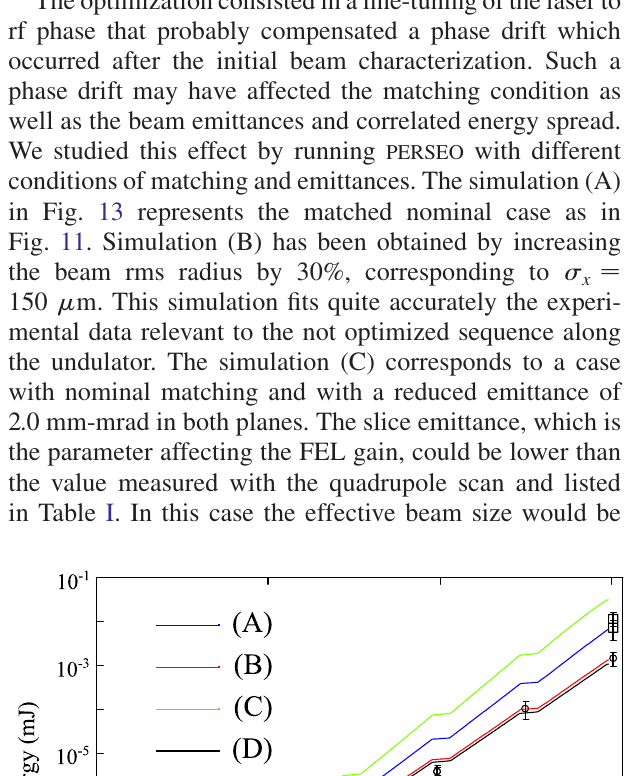
¼ 120 (cid:2) m ; (B) r ¼ 150 (cid:2) m ; r ¼ 100 (cid:2) m ; r